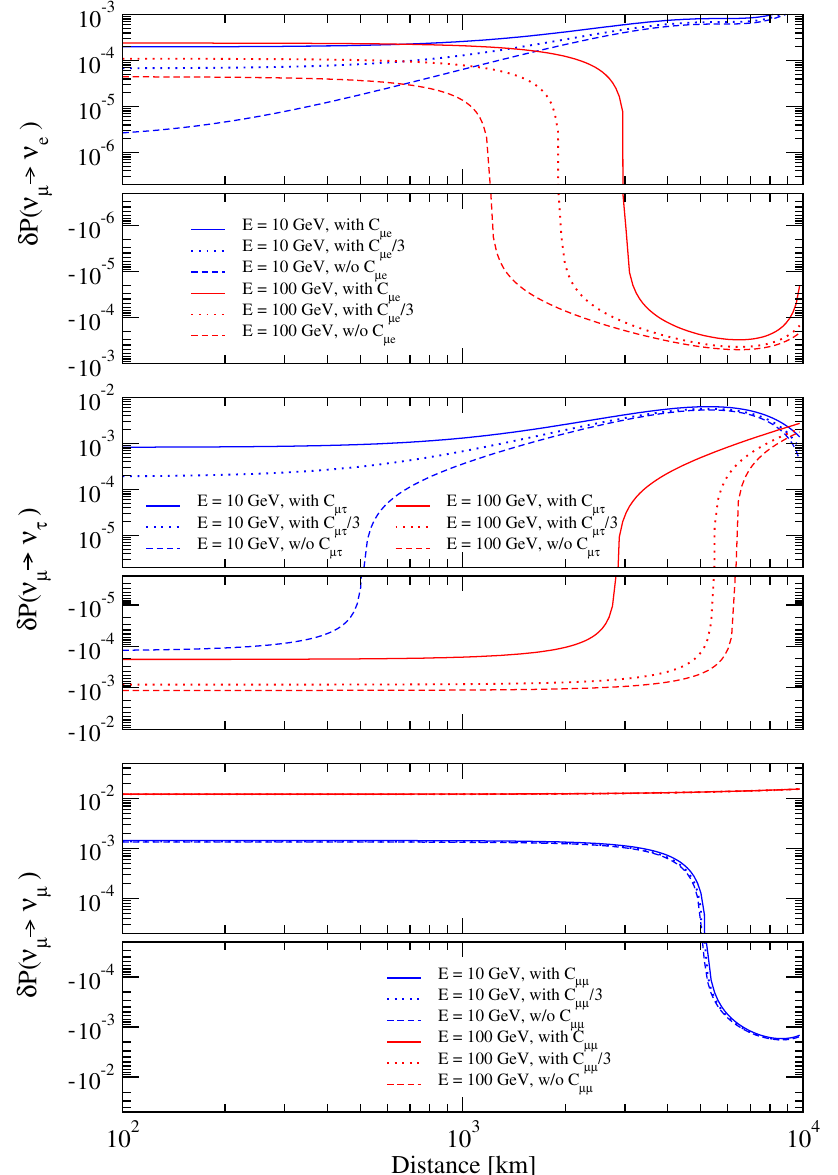
Figure 4 . The sum of the order W 2 correction terms in eq. (3.48) plus the probability leaking term C (cid:22)(cid:11) (see eq. (2.3) for de(cid:12)nition) in P ( (cid:23) (cid:22) ! (cid:23) (cid:11) ), namely, (cid:14)P ( (cid:23) (cid:22) ! (cid:23) (cid:11) ) (cid:17) C (cid:22)(cid:11) + P ( (cid:23) (cid:22) ! (cid:23) (cid:11) ) (2) is plotted assuming a common m 2 = 0 : 1 eV 2 . The top, middle and bottom panels are for (cid:11) = e; (cid:28) , J and (cid:22) , respectively. In each panel the three cases are shown: N = 1 case with maximal C (cid:22)(cid:11) (solid line), the universal scaling model with N = 3 (dotted line), and the order W 2 correction terms only (dashed line). The last case corresponds to the universal scaling model with N = 1 . The blue lines are for E = 10 GeV, and the red for E = 100 GeV. The leaking terms in the N = 1 model (shown without superscript ( N = 1) in the legend) have values C e(cid:22) = 2 (cid:2) 10 (cid:0) 4 , C (cid:28)(cid:22) = 9 : 5 (cid:2) 10 (cid:0) 4 , and C (cid:22)(cid:22) = 9 : 6 (cid:2) 10 (cid:0) 5 .